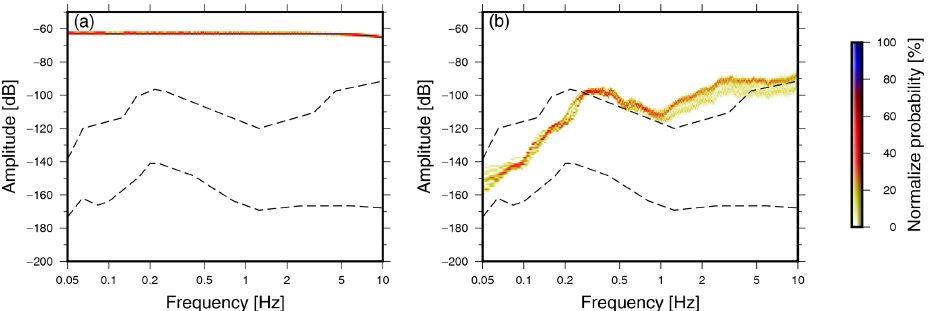
Figure 7. PDFs of the LSM IMU accelerometer (a) and the Streckeisen STS-2 connected to a Quanterra Q330 (b) for 24h of continuous recording in dB re m 2 s − 4 Hz − 1 . The dotted lines indicate the seismic high and low ambient noise levels (Peterson,